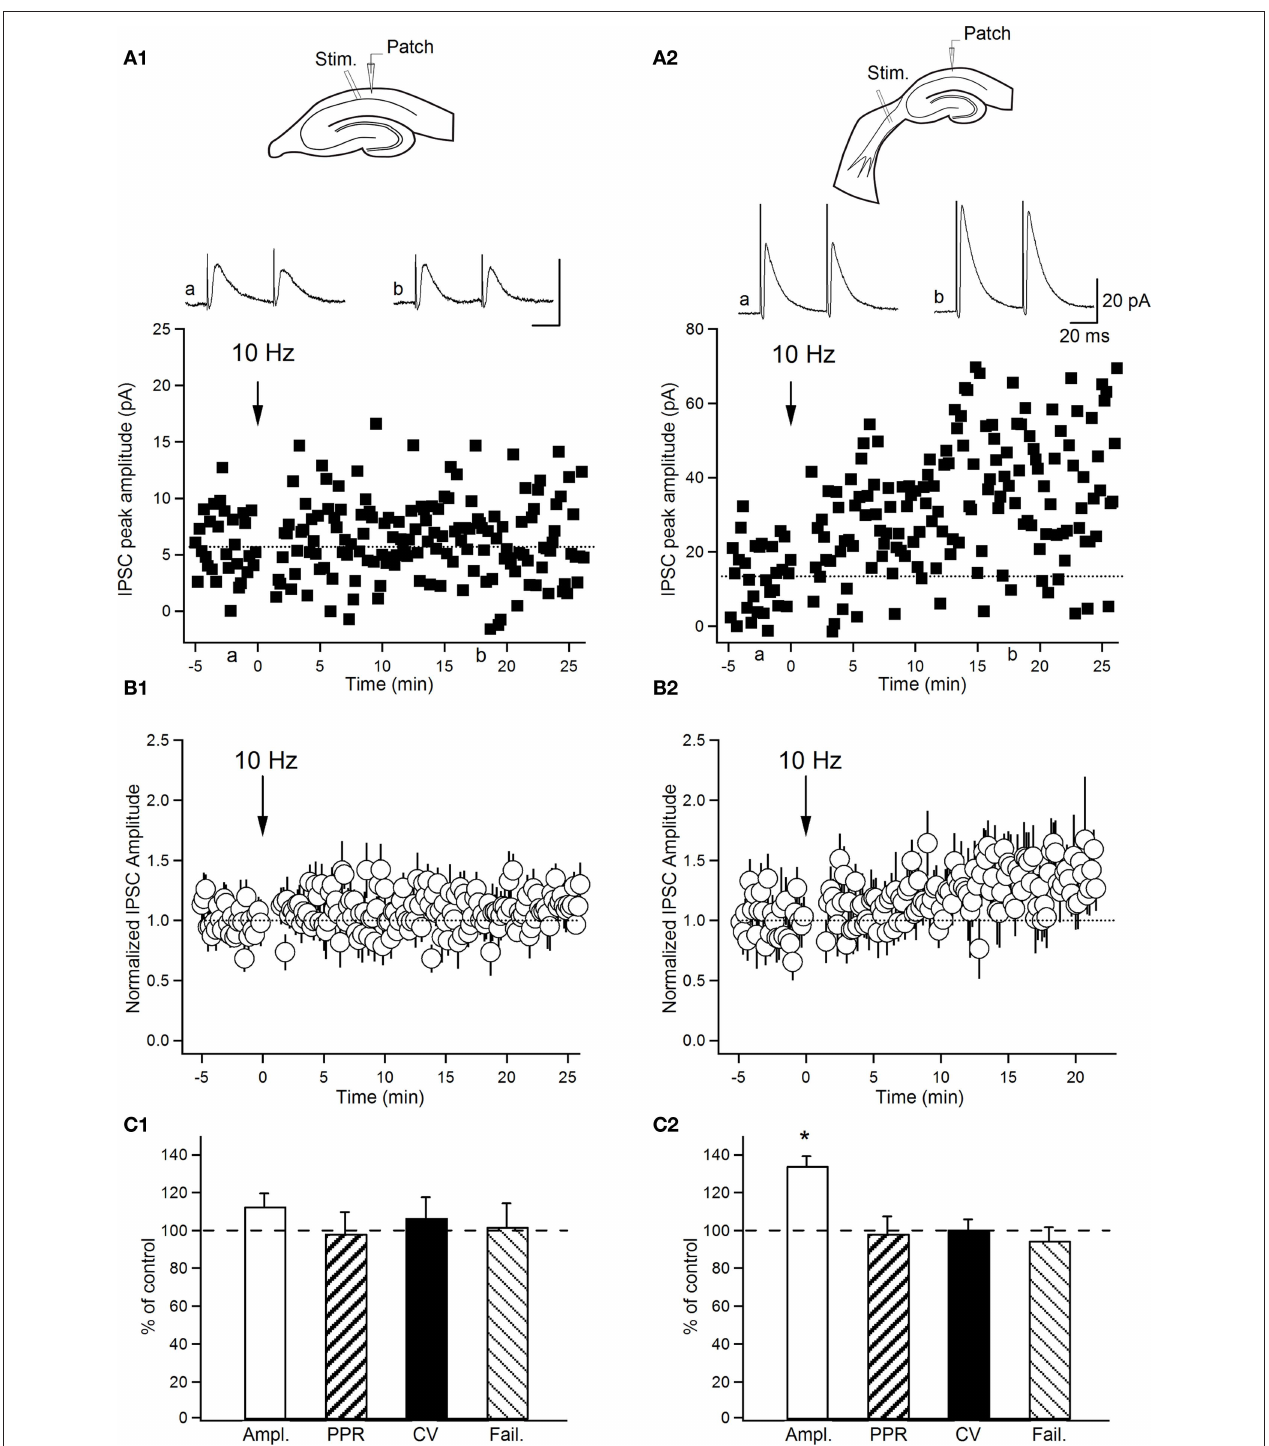
of group data ( C1 , n = 5; C2 , n = 5) for experiments illustrated in (B) showing changes in the eIPSC peak amplitude, the paired-pulse ratio (PPR), the coefficient of variation (CV) and the failure rate obtained 20 min after 10-Hz stimulation. Data are expressed as percentage of control parameters obtained before 10-Hz stimulation. * P < 0.05. Error bars throughout represent